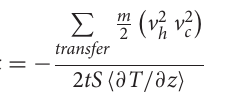
boundary conditions are selected in the other two directions.